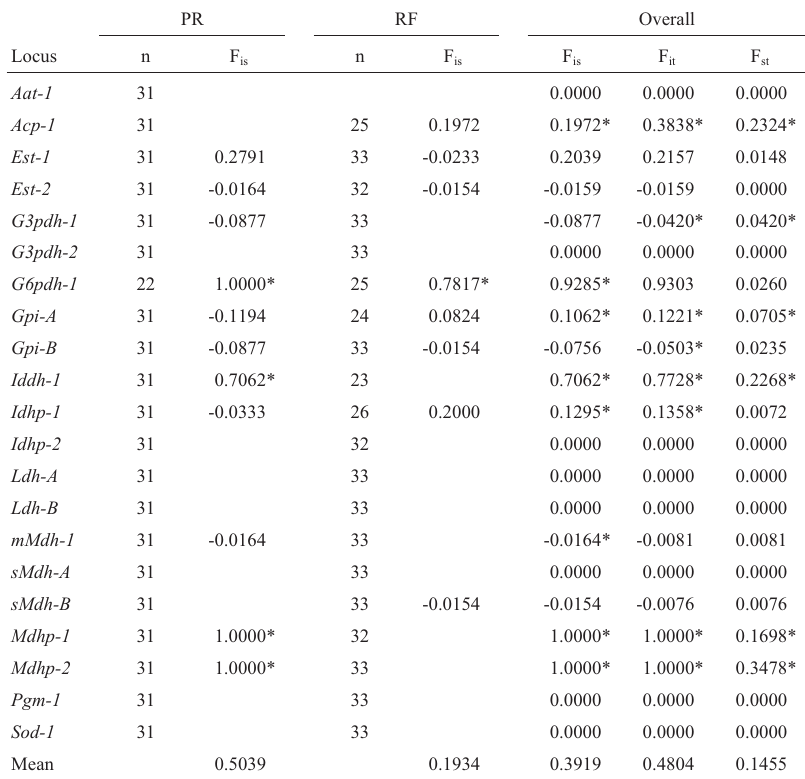
Table 3 - Wright’s statistics for Astyanax altiparanae from the Upper Paraná River (PR) and Ribeirão Ficha (RF). PR